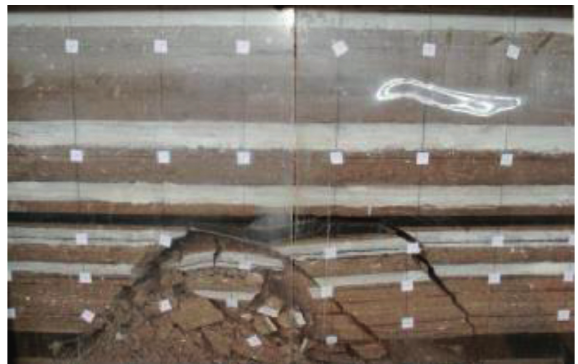
Figure 3: Typical map of roof caving with a thickness of